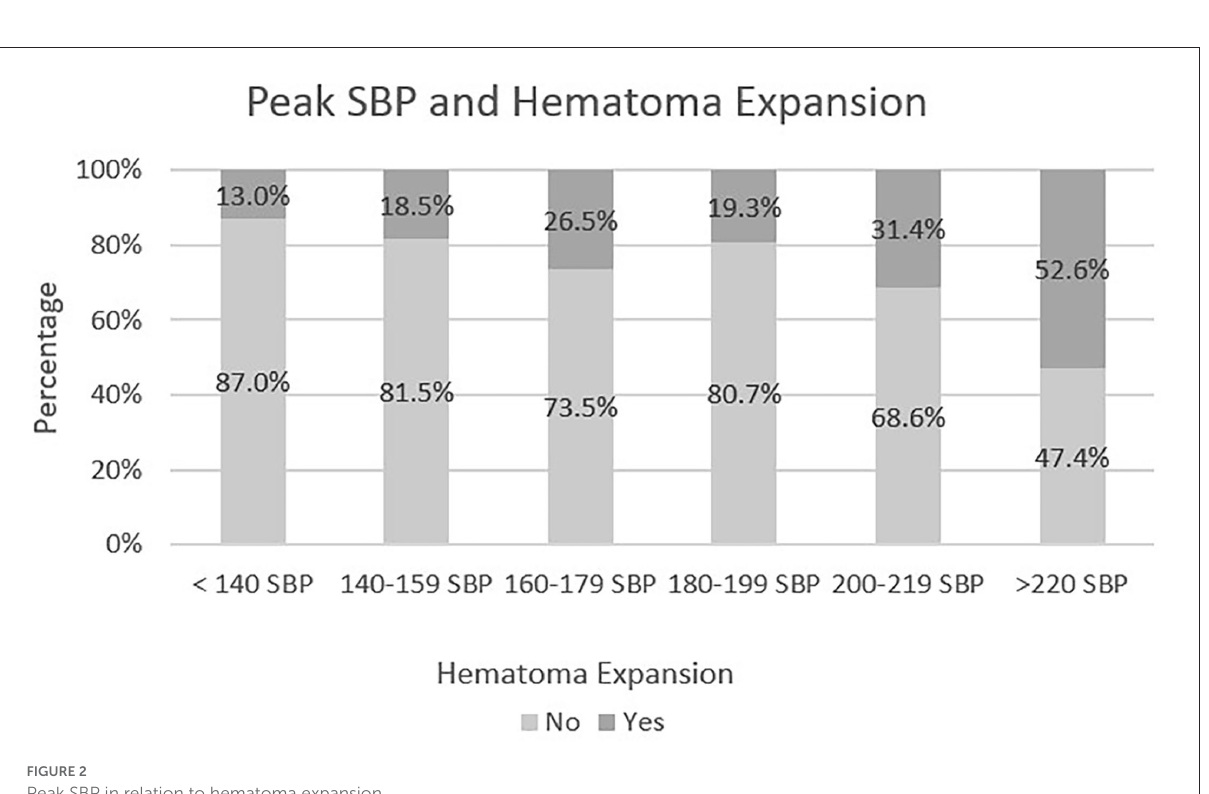
FIGURE2 Peak SBP in relation to hematoma